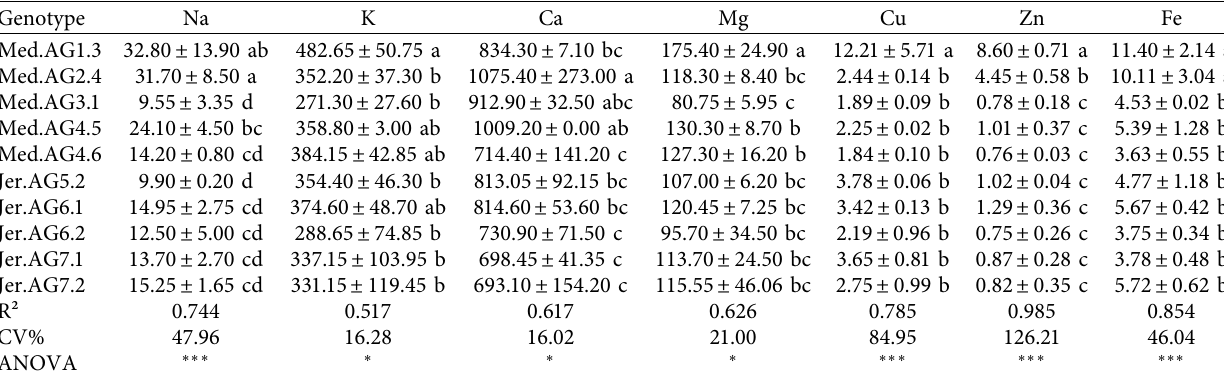
Table 2: Mineral compounds (mg.100 g − 1 DM) determined by atomic absorption spectrometry in millet genotypes grains.